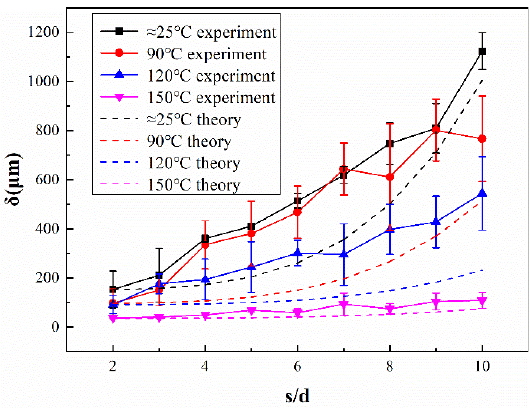
Figure 9. Collapse profile of silicon foams fabricated with different filament spans.